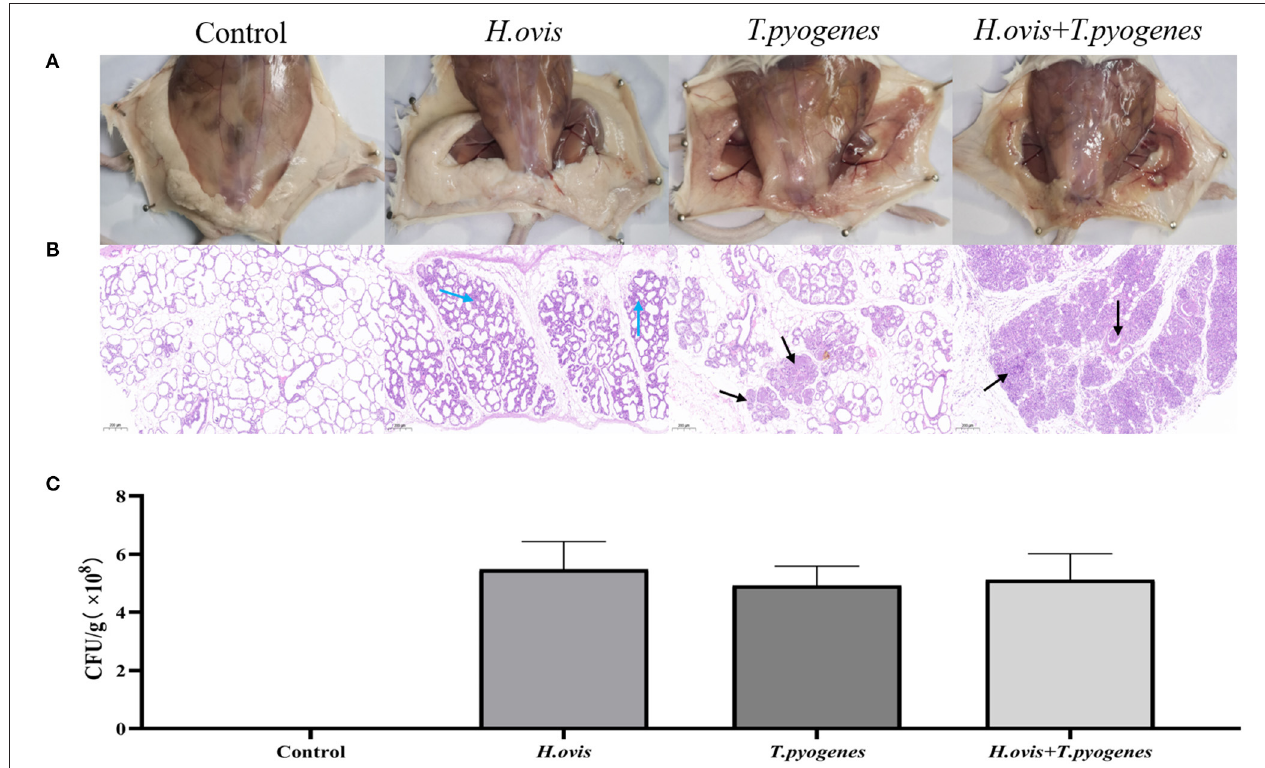
FIGURE 4 | Inflammation and histological evaluation and bacterial burden of murine mammary gland after intramammary inoculation with Helcococcus ovis , Trueperella pyogenes , Helcococcus ovis , and Trueperella pyogenes. (A) Pathological changes in murine mammary glands challenged with Helcococcus ovis , Trueperella pyogenes , Helcococcus ovis , and Trueperella pyogenes . (B) Helcococcus ovis induced murine mastitis, with stromal hyperplasia and mammary alveolar damage (blue arrow) after infection. Trueperella pyogenes induced murine mastitis, with an increased infiltration of inflammatory cells (mainly neutrophils) into the gland alveoli (black arrow) and progressive mammary alveolar damage after infection. Helcococcus ovis and Trueperella pyogenes co-infection induced murine mastitis, with an increasing number of inflammatory cells (mainly neutrophils) infiltrated into the gland alveoli (black arrow), stromal hyperplasia, and progressive mammary alveolar damage after infection. (C) Bacterial burden in mammary glands of mice (24h after inoculation). Each group represents five mice in each of the four groups. Data are mean ± SD of three independent